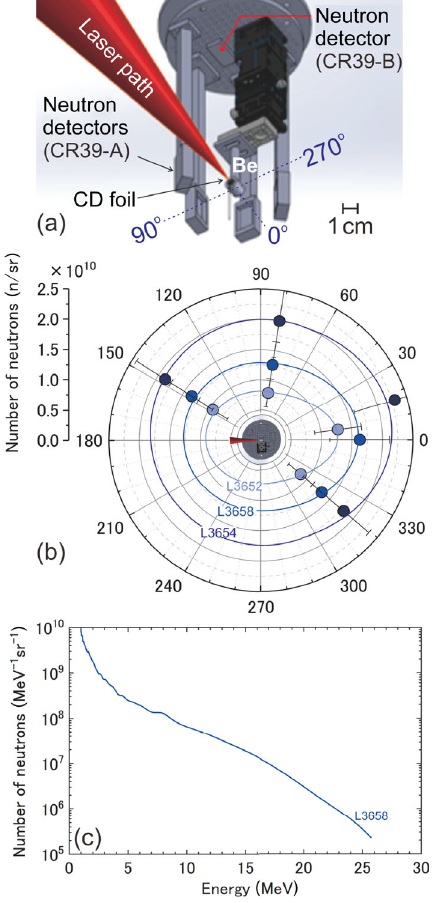
FIG. 3. (a) Setup of the LDNS and neutron detectors placed in the horizontal plane (CR39-A) and the vertical direction (CR39-B) of the LDNS. (b) Angular distributions of the neutrons measured by the CR39-A detectors for three different laser shots. The neutron yields of around 0° and 90° are used for the scaling in Fig. 4. (c) Energy distribution of the fast neutrons in the MeV range measured by the TOF detector